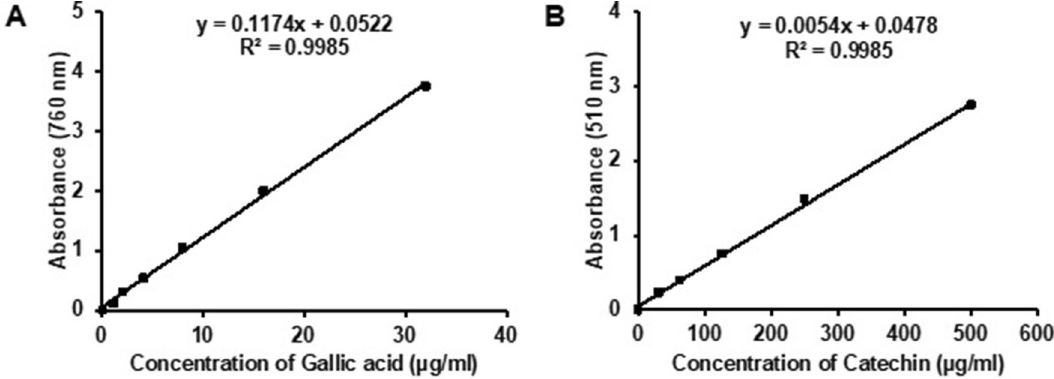
Figure 5. Standard curve of gallic acid ( A ) and catechin ( B ) for determining total phenolics and total flavonoids, respectively. The plot represents the mean ± SD from three